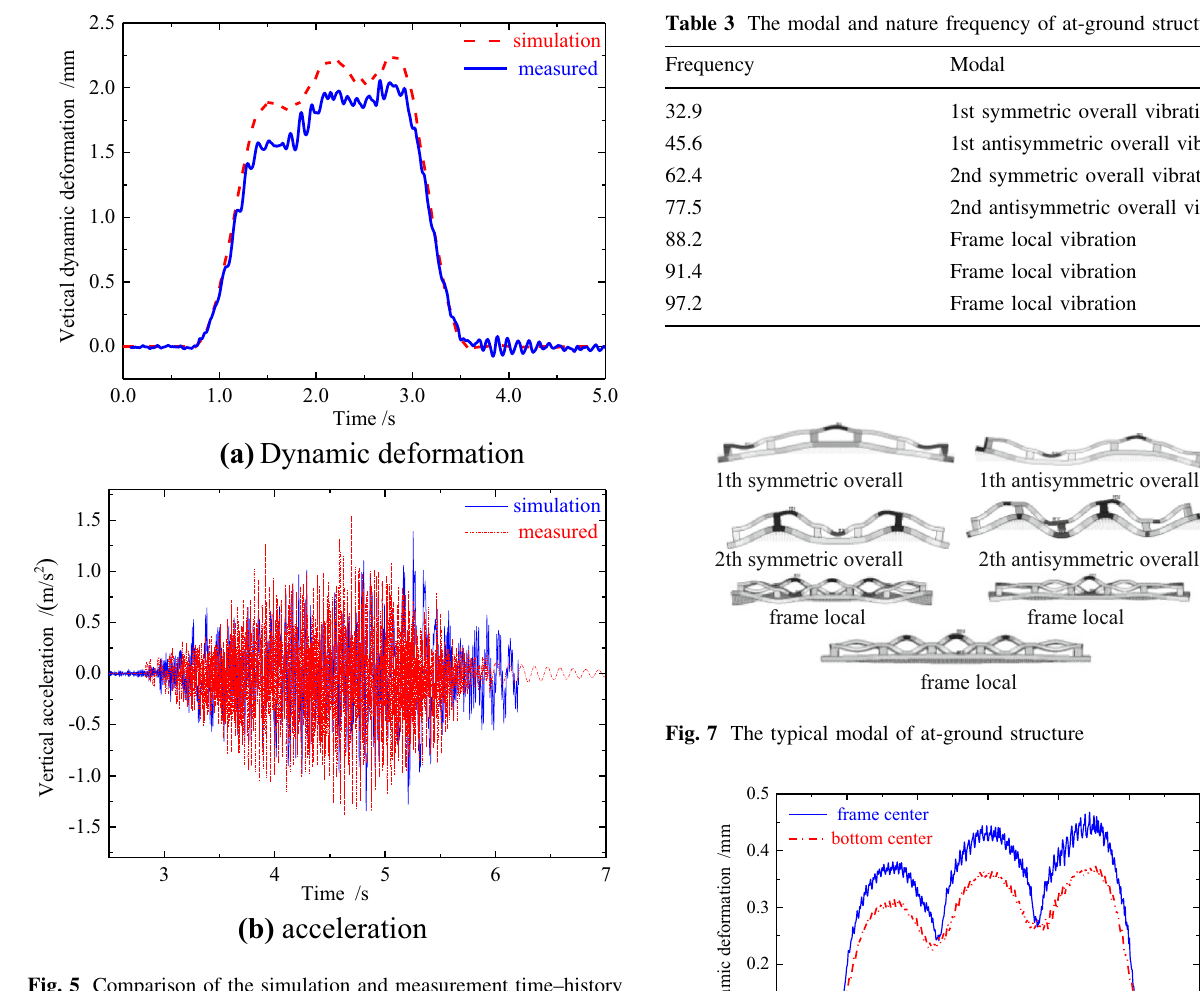
Fig. 5 Comparison of the simulation and measurement time–history curves. a Dynamic deformation. b Acceleration